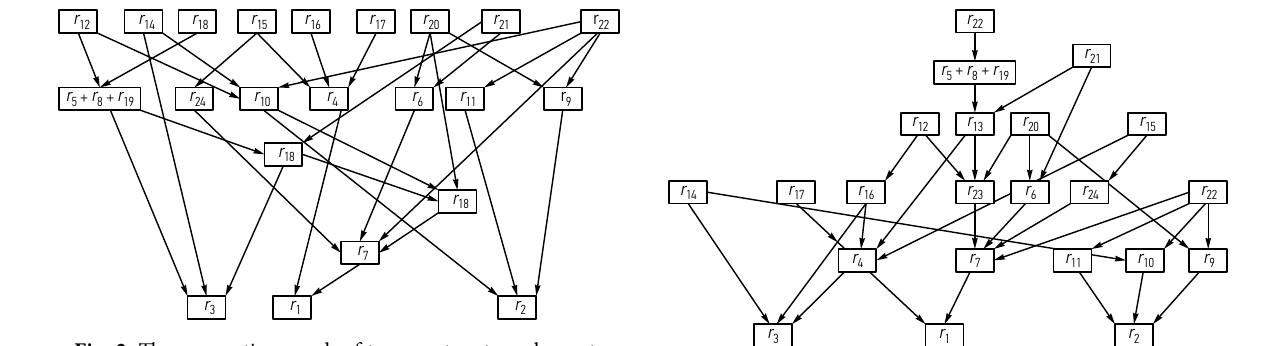
Fig. 2. The connecting graph of transport system